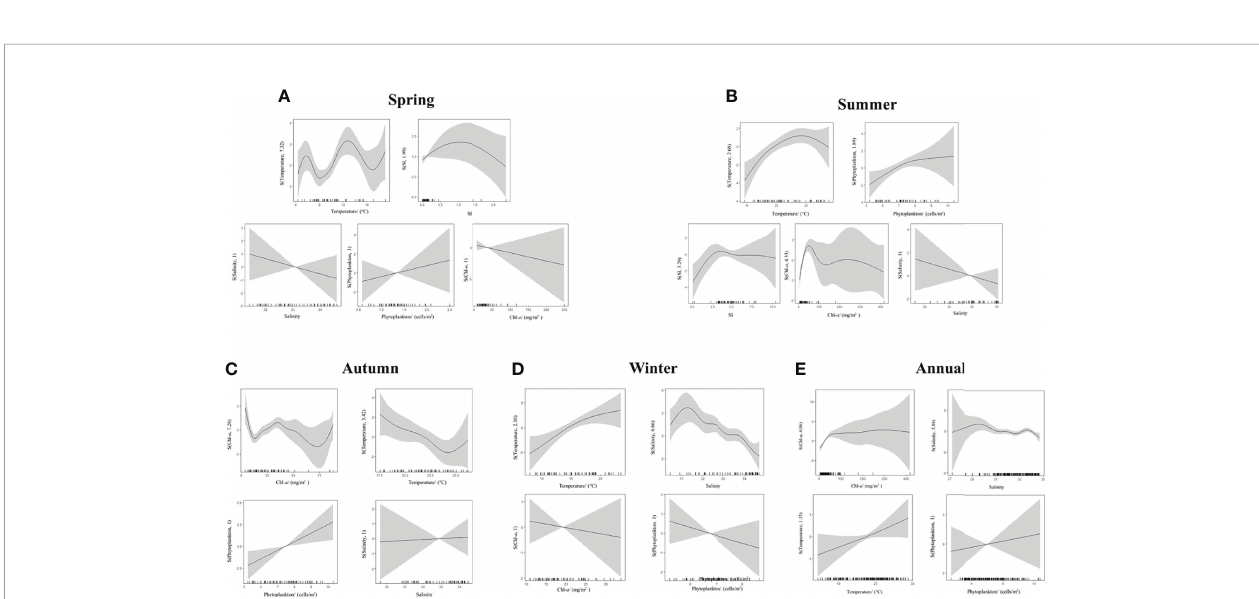
FIGURE 7 | Results of GAMs for the relationship between N. scintillans abundance and environmental